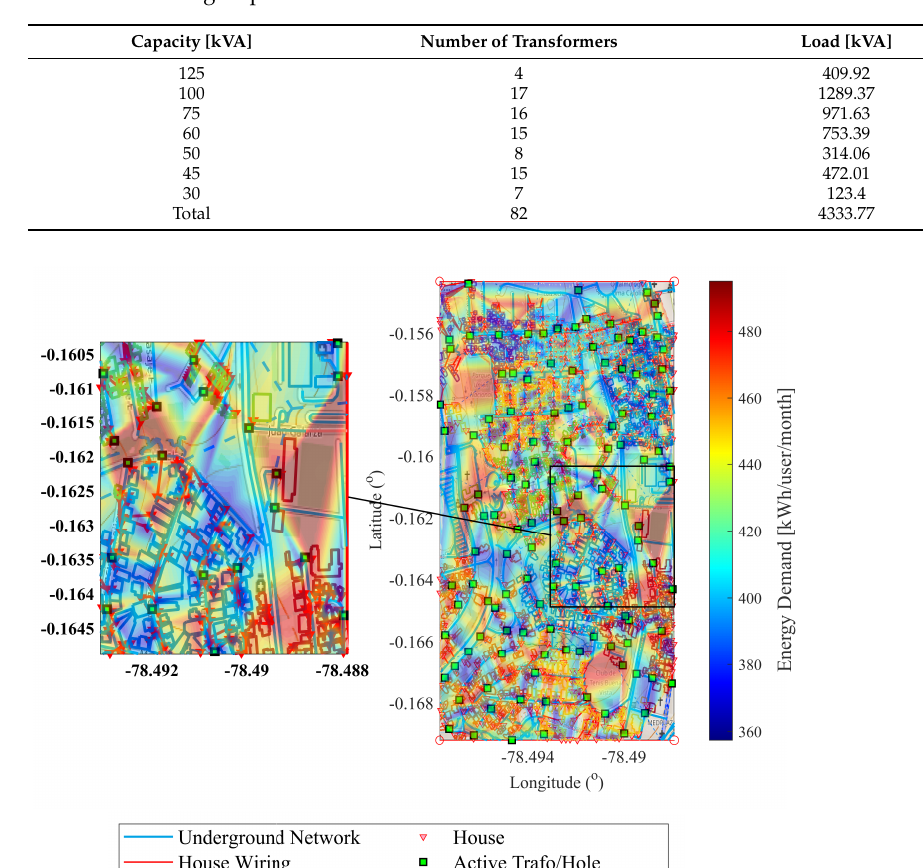
Figure 11. Heat map of energy demand per user per month in Quito Tenis of Ecuador for a stratum A.